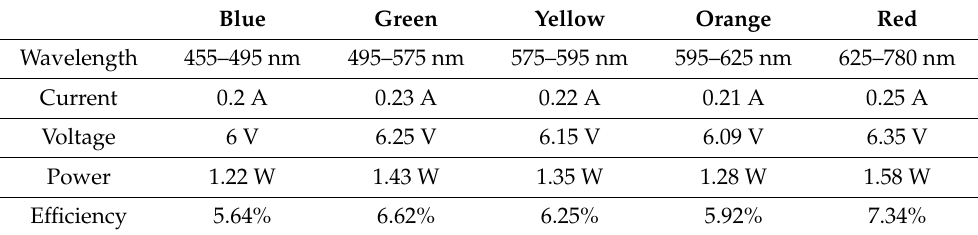
Table 7. Output power and efficiency of the solar cells [264]. Blue Green Yellow Orange